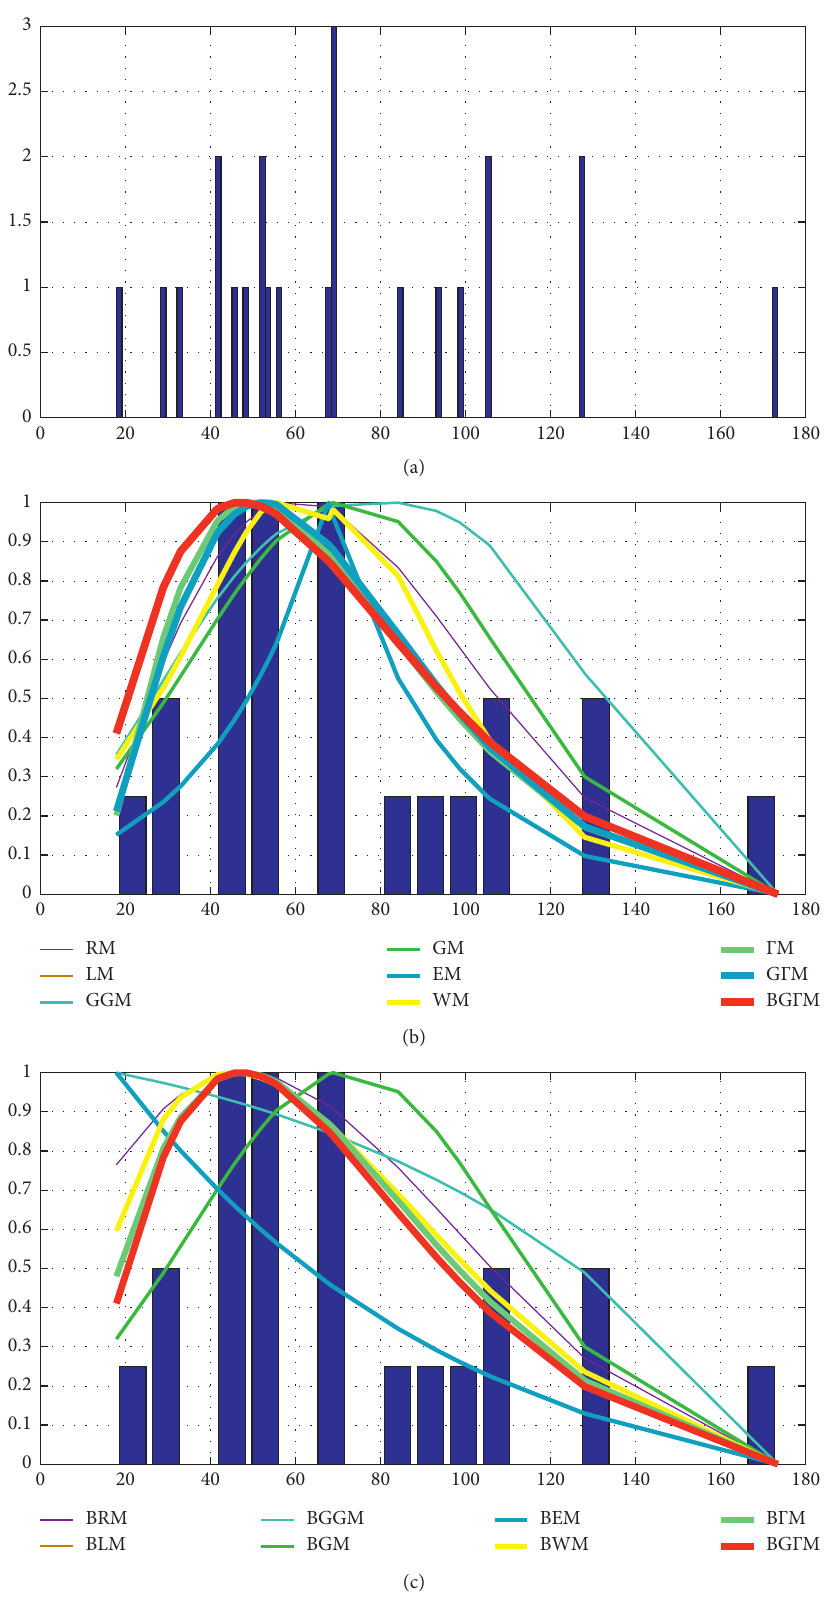
Figure 7: The estimated histogram. (a) The histogram of the tests on endurance of deep groove ball bearings; (b) the estimated histogram of RM, LM, WM, GM, EM, GGM, Γ M, G Γ M, and G Γ M; (c) the estimated histogram of BRM, BLM, BWM, BGM, BEM, BGGM, B Γ M, and BG Γ